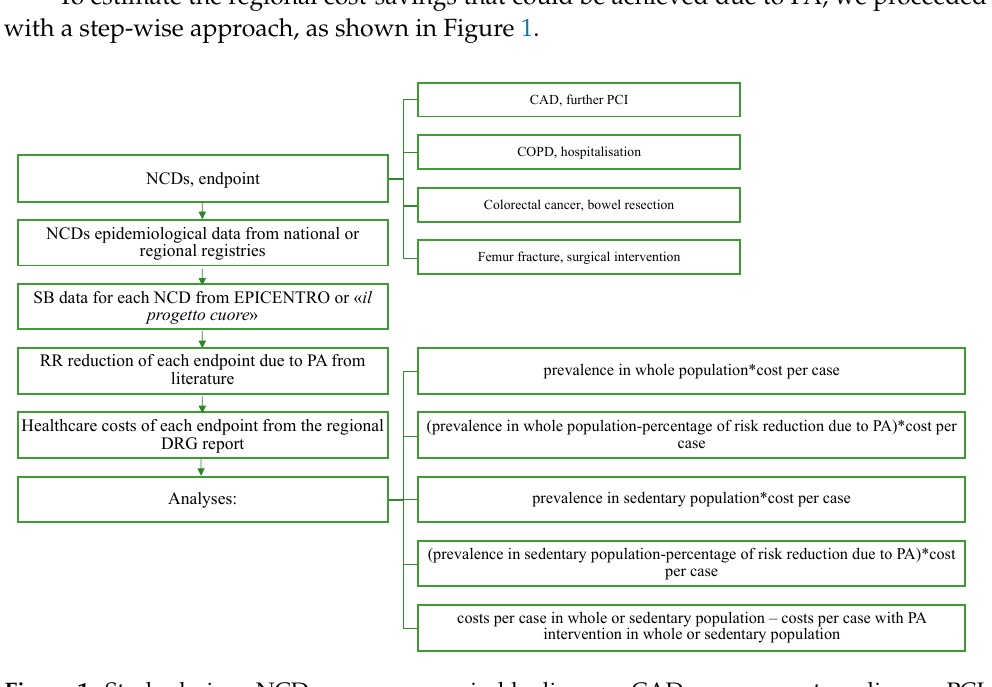
Figure 1. Study design. NCDs: non ‐ communicable diseases, CAD: coronary artery disease, PCI: percutaneous coronary intervention, COPD: chronic obstructive pulmonary disease, SB: sedentary behaviour, EPICENTRO: epidemiology website for public health, RR: relative risk, PA: physical activity, DRG: diagnosis-related groups; *: multiplication